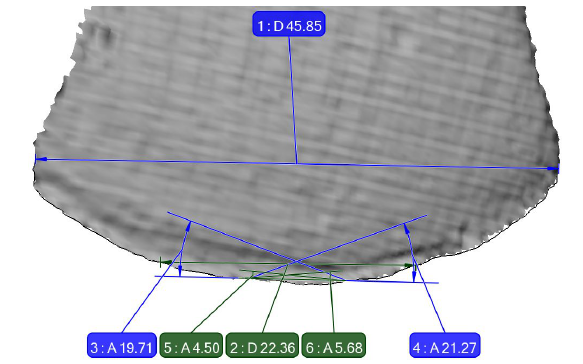
Figure 4. Hand Tool Nr.2 – CAD-based width and slope analysis of the cutting edge (distances in mm, angles in degrees); the blue parameters are representing the complete shapes, the green values were created after average width calculations of their test tool